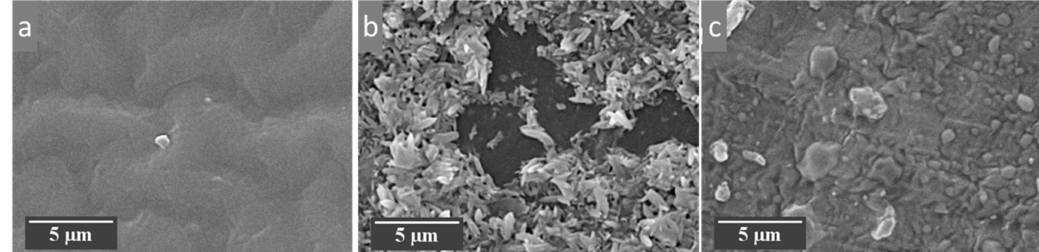
Figure 9. SEM images of the inner surface of ( a ) a “pristine” pouch, compared to ( b ) and ( c ) a surface from a reclaimed pouch (from a QC reject cell) that has been washed and dried. It is clear that some modification of the surface has